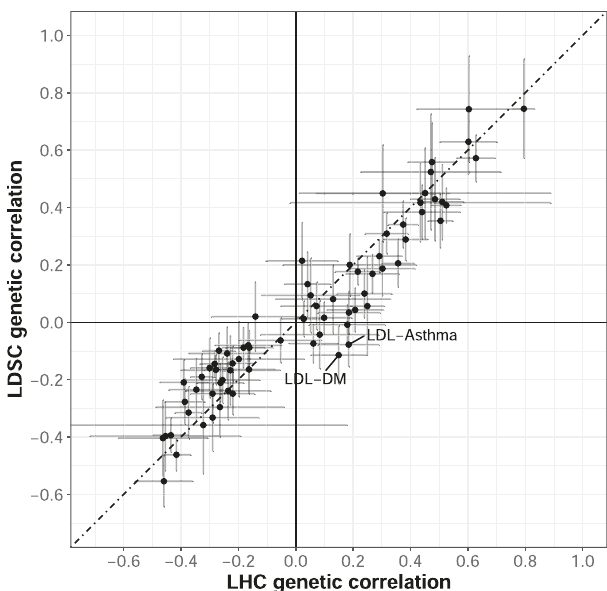
Fig. 6 Scatter plot comparing the genetic correlation for each trait obtained from LDSC against the value calculated using parameter estimates from the LHC-MR model. LHC-MR calculated genetic correlations from 200 parameter estimates generated during the block- jackknife procedure, where the mean values of these 200 estimates are shown here. A 95% CI for both method-calculation is shown for each point, and pairs with an absolute value difference > 0.2 are labelled. Values from both methods are reported in Supplementary Data